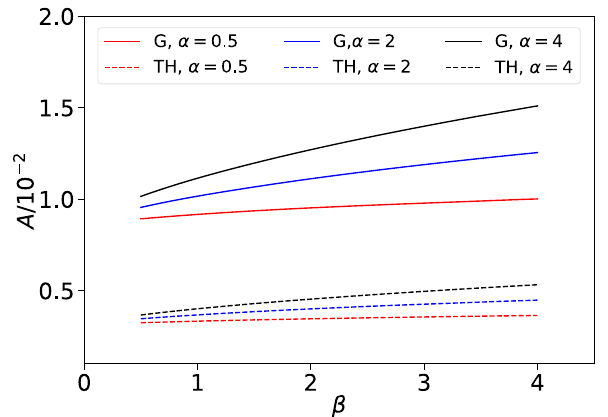
Fig. 5 The convex curves denote the energy density of SIGWs, where the corresponding PBHs can explain all dark matter. The black and red curves represent the situations where the Gaussian window function and real-space top hat window function are chosen to calculate the corresponding PBH mass function, respectively. The dashed and solid lines are from the parameterization (32) with the broadest peak and the narrowest peak,